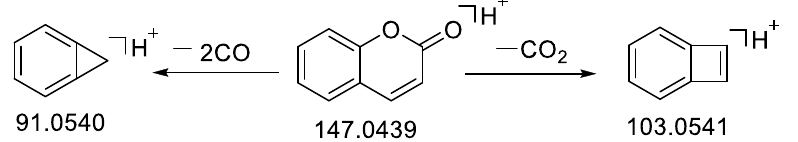
Figure 5. Fragmentation pathway of coumarin in positive ion mode.